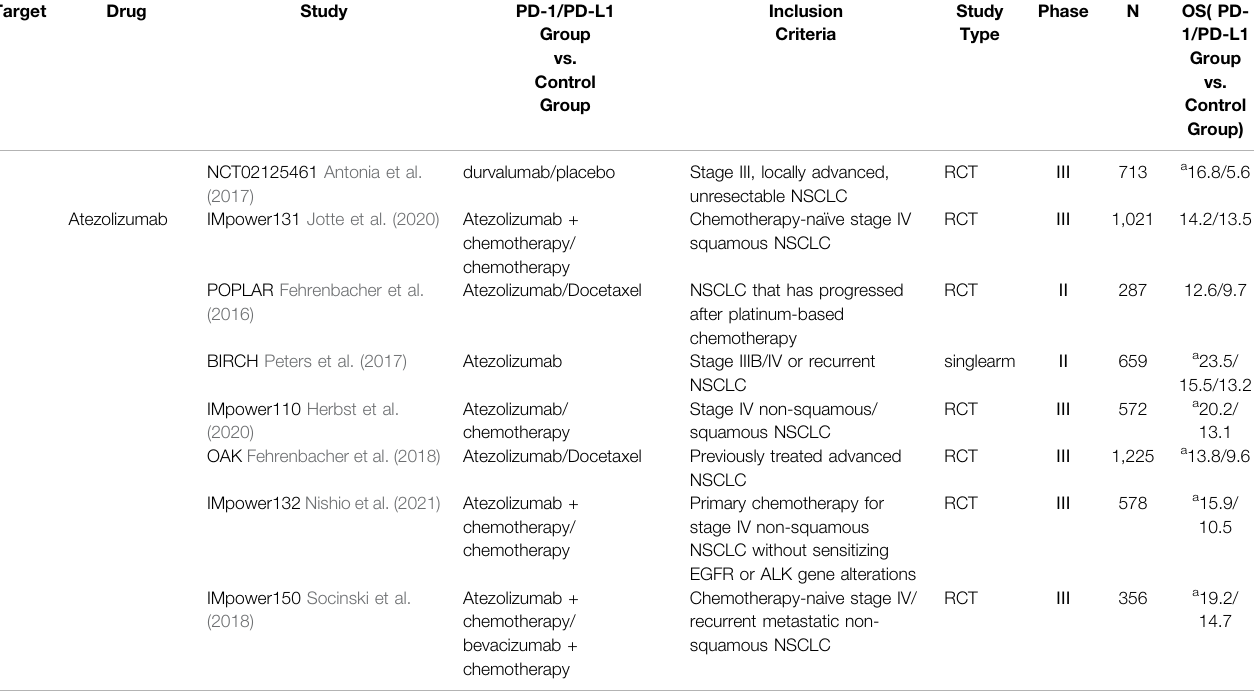
Table 3 is a summary of the clinical trials with PD-1/PD-L1 inhibitors that are widely used in advanced NSCLC in China